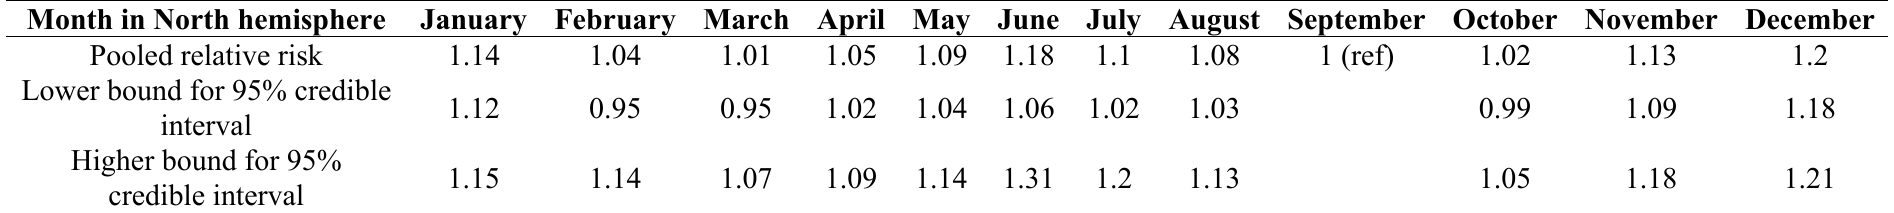
Table A17. Pooled relative risks and 95% credible interval for the association between month of birth and preterm birth after excluding [56].